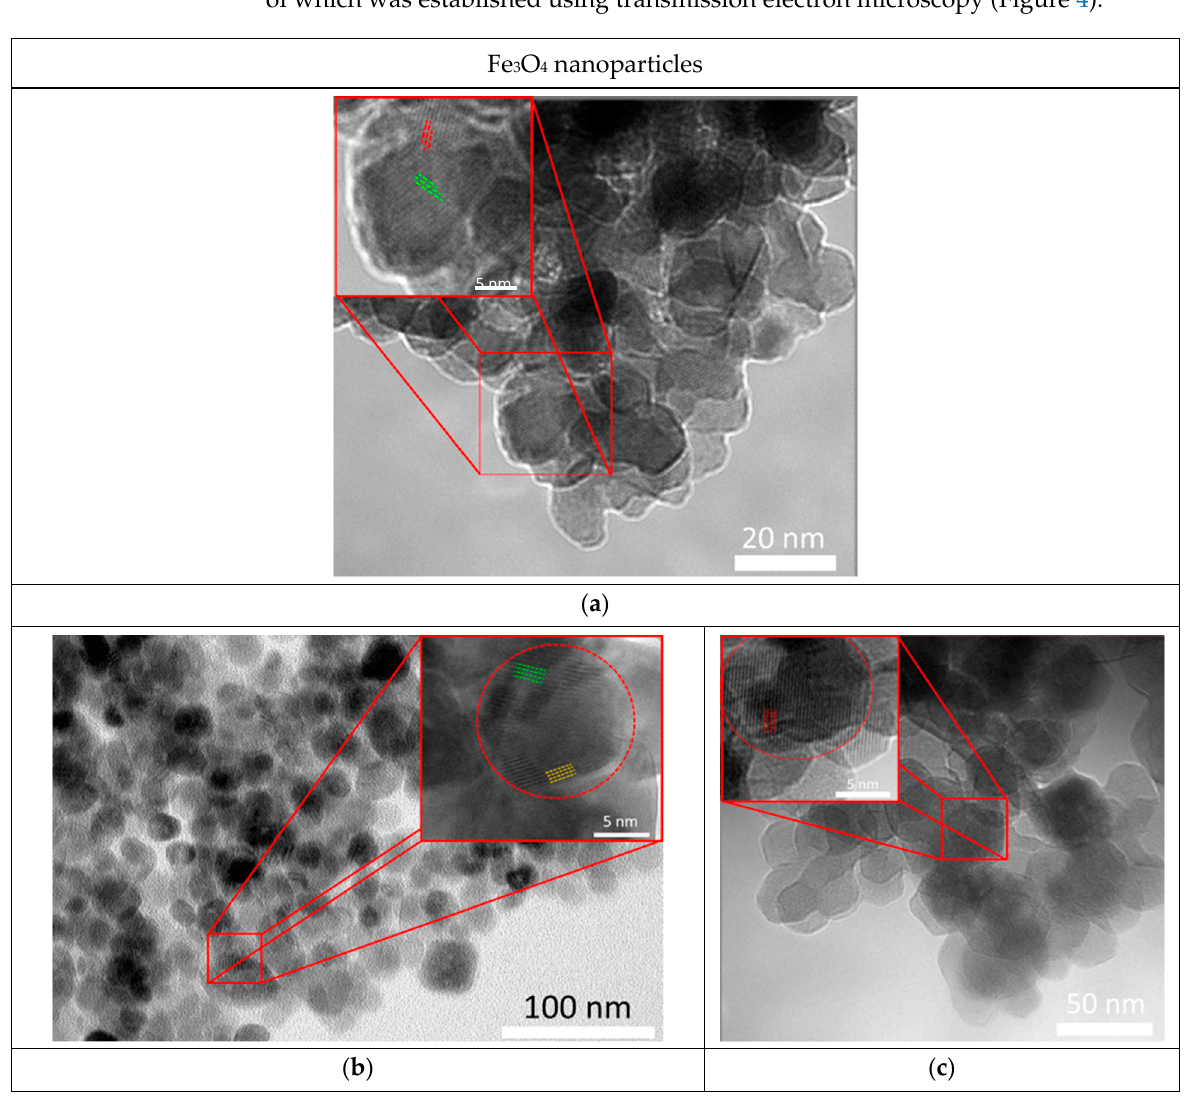
Figure 3. ( a ) TEM images of studied initial (Initial) and annealed (Annealing) ( a ) Fe 3 O 4 nanoparticles at temperatures of 400 °C ( b ) and 600 °C ( c ).